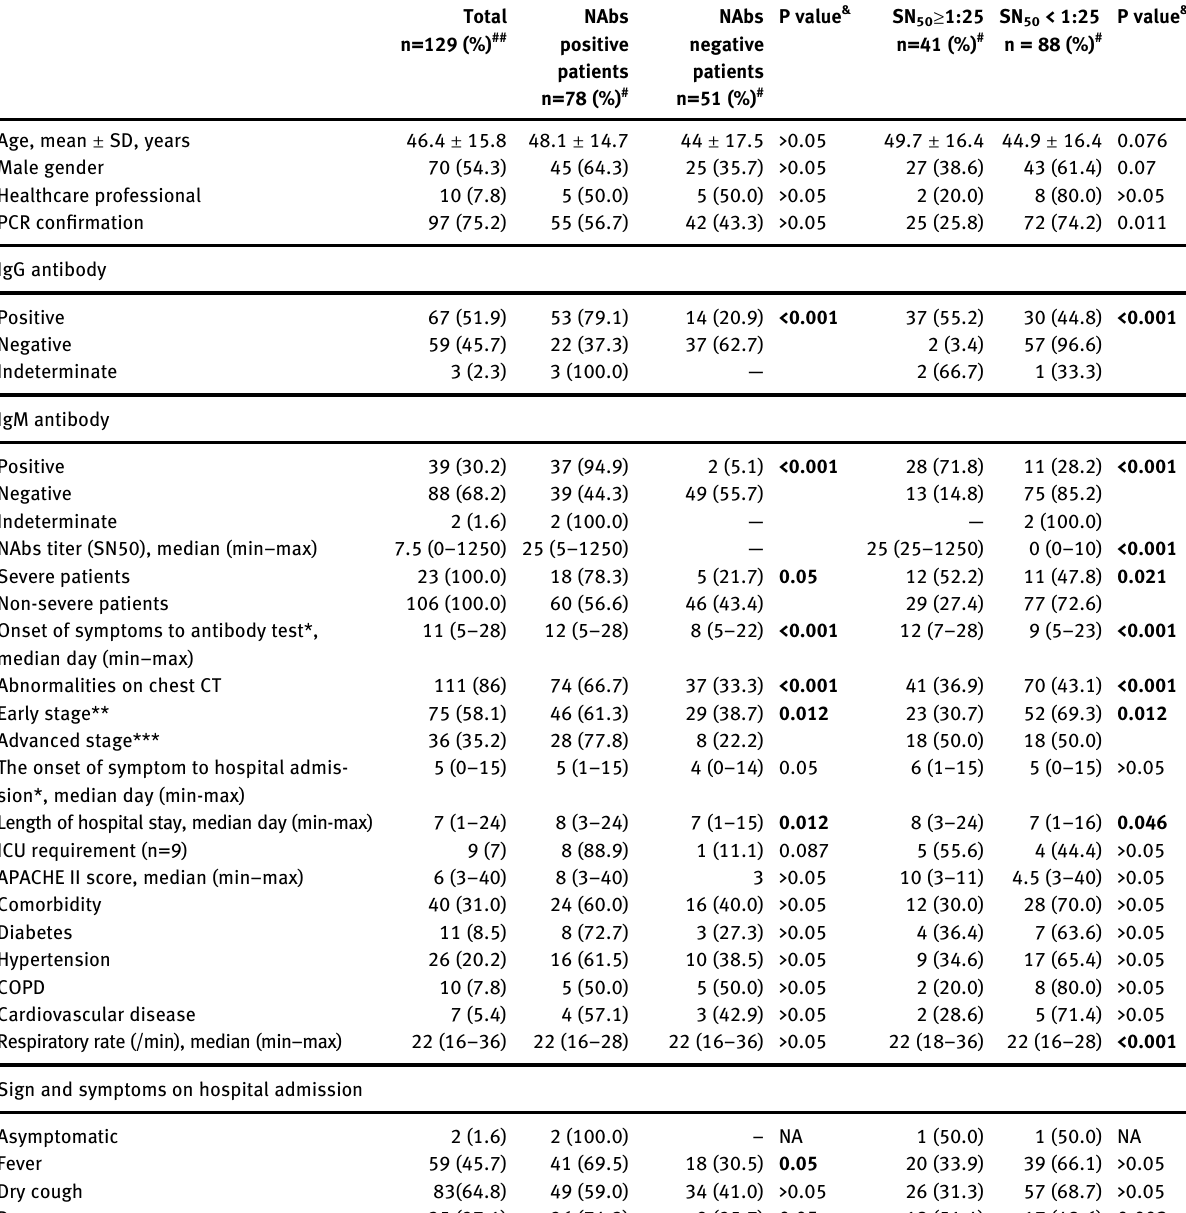
Table  : Demographic, clinical, and radiologic characteristics of the patients with COVID- 